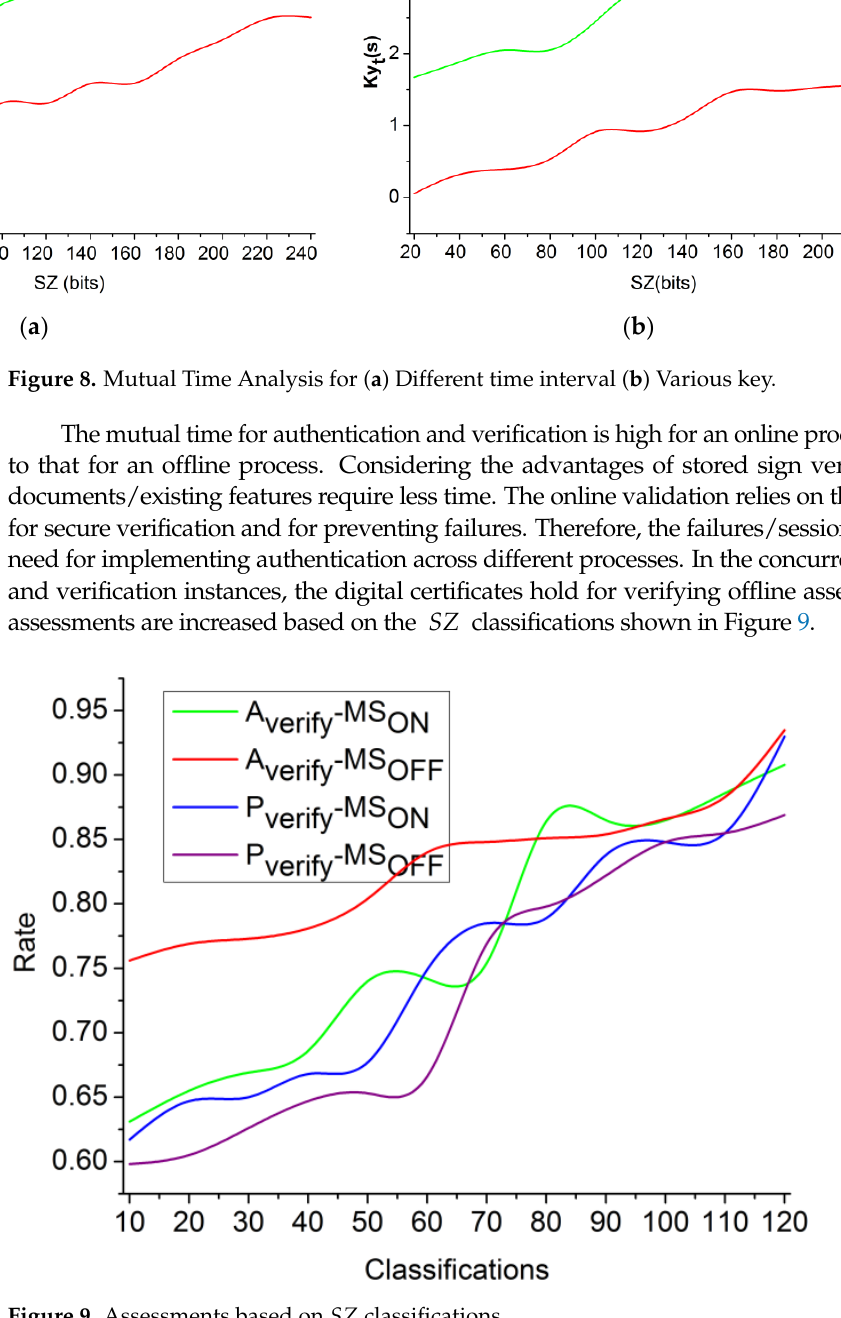
Figure 9. Assessments based on 𝑆𝑍